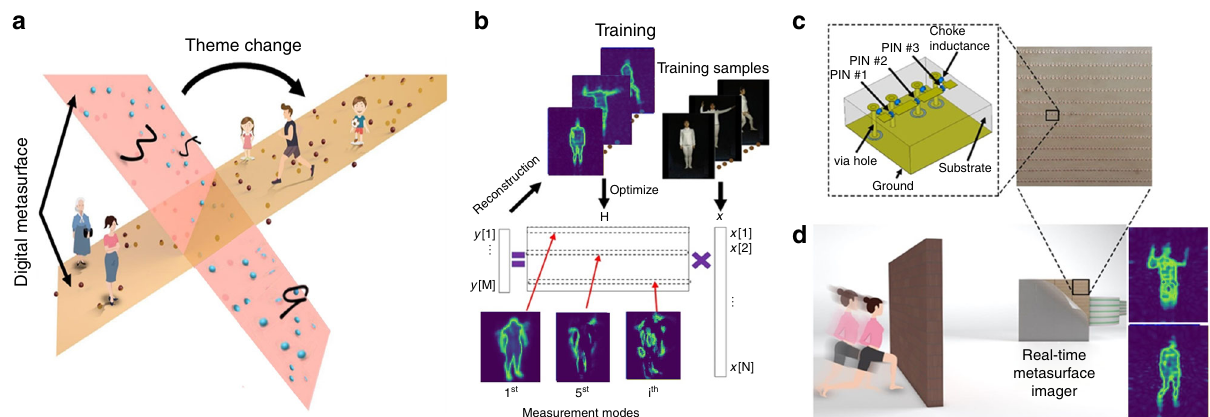
Fig. 1 Working principle of the real-time digital-metasurface imager. a The proposed machine-learning metasurface imager can be optimized for different kinds of scenes. The optimization is performed by training the manifold representing the metasurface con fi guration (the surfaces) to be close to the training data (scatters). b The illustration of training the reprogrammable imager by using the PCA method (see Supplementary Note 2), in which the training person is Hengxin Ruan (coauthor). c The map of coding metasurface and the unit cell (see Supplementary Fig. 1, 2). d The illustration of real-time reprogrammable metasurface imager imaging a moving person behind a wall. Two reconstructions are displayed at right (more experimental results